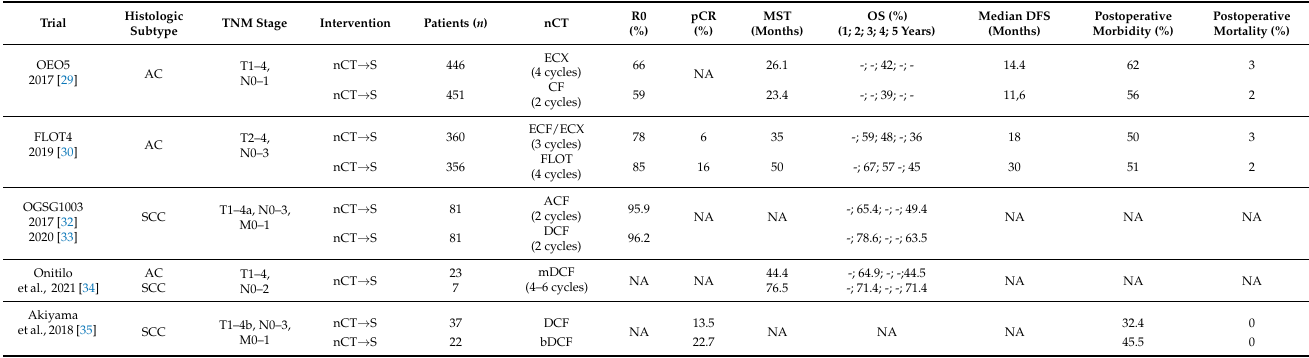
Table 2. Comparison between different regimens of